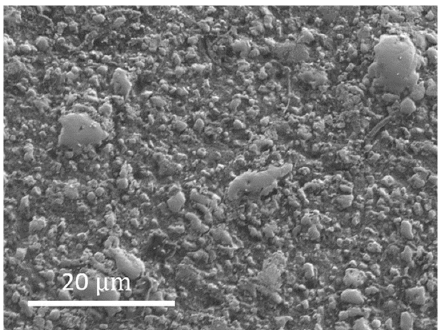
Figure 6. High-resolution SEM image of the (Hf, Mo, Nb, Ta, Zr)B 2 sample showing an average grain size of 2 microns. The few large grains observed in this micrograph are also from the (Hf, Mo, Nb, Ta, Zr)B 2 sample.